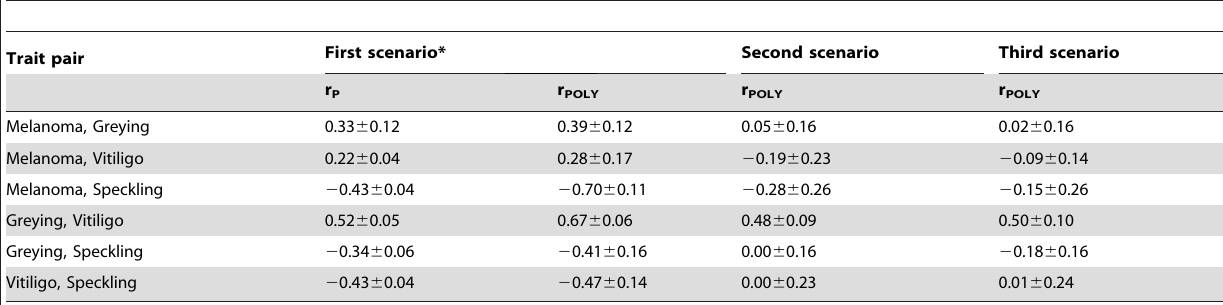
Table 3. Phenotypic (r P ) and genetic correlations from polygenic components (r POLY ) for melanoma grade, grey level, vitiligo grade, and speckling grade estimated using different